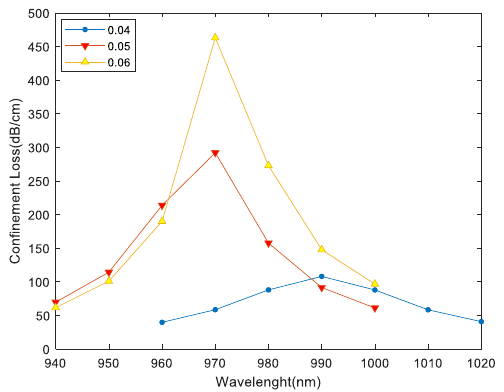
FIGURE 5. Dependence of confinement loss on the gold film thickness. (d=2 μ m, d c =2.8 μ m, h a =0.45 μ m, n a =1.45, n c